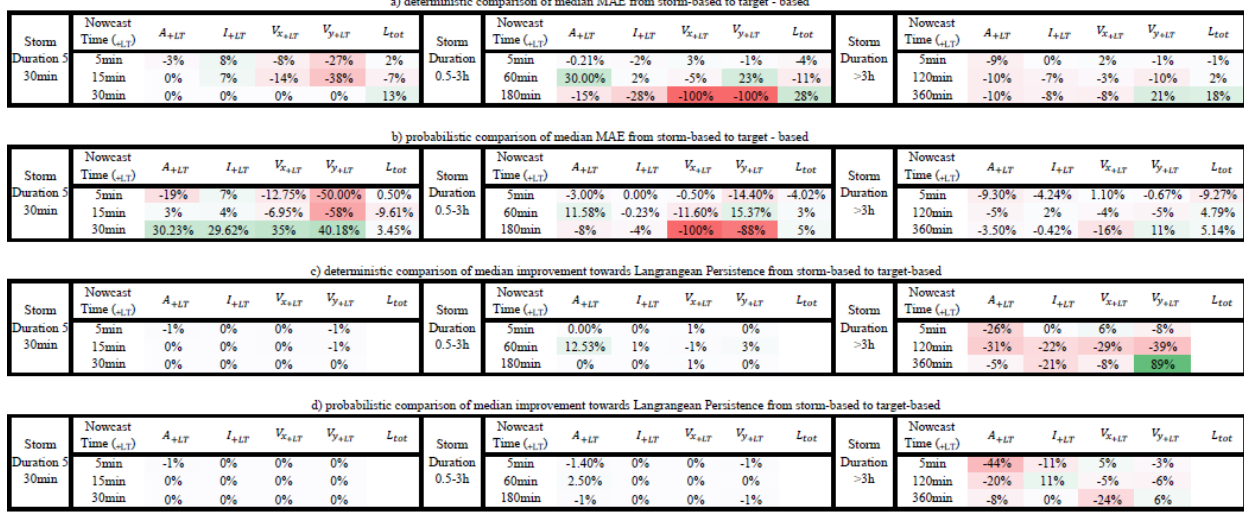
Table 5. Median deterioration (–) or improvement ( + ) of k -NN storm-based (VS2) compared to target-based (VS1) over all lead times according to the storm duration and nowcast times (shown in percentage). Equation (11) is used here, where “ref” is the target-based and “new” is the storm-based k